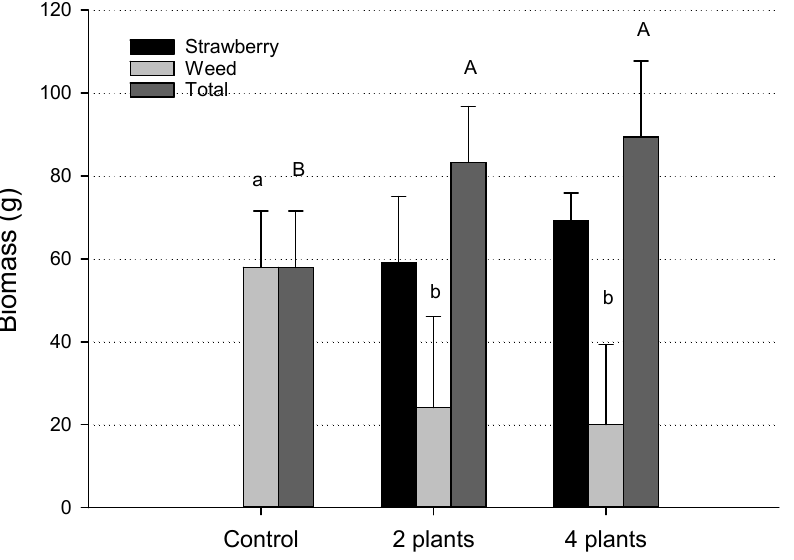
Figure 6. Dry biomass of strawberry, weeds and total (mean ± SD) found in 0.25 m 2 in the row. Different letters indicate significant differences for Tukey’s HSD test for weed and total biomass.